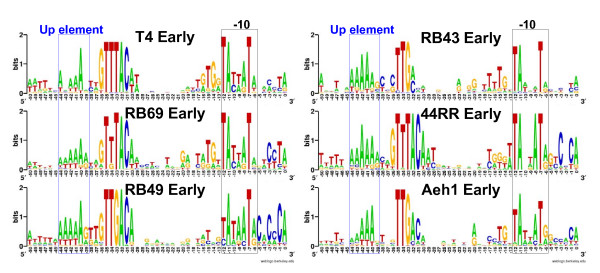
Sequence logo representation of putative early promoter consensus for each genome. Sequences were identified using fuzznuc [24] and HMMer [53]. Consensus sequences were plotted with WebLogo [54]. Height of letter indicates degree of conservation. Nucleotide 0 is the putative transcription start site. Putative up elements and the -10 region are boxed.